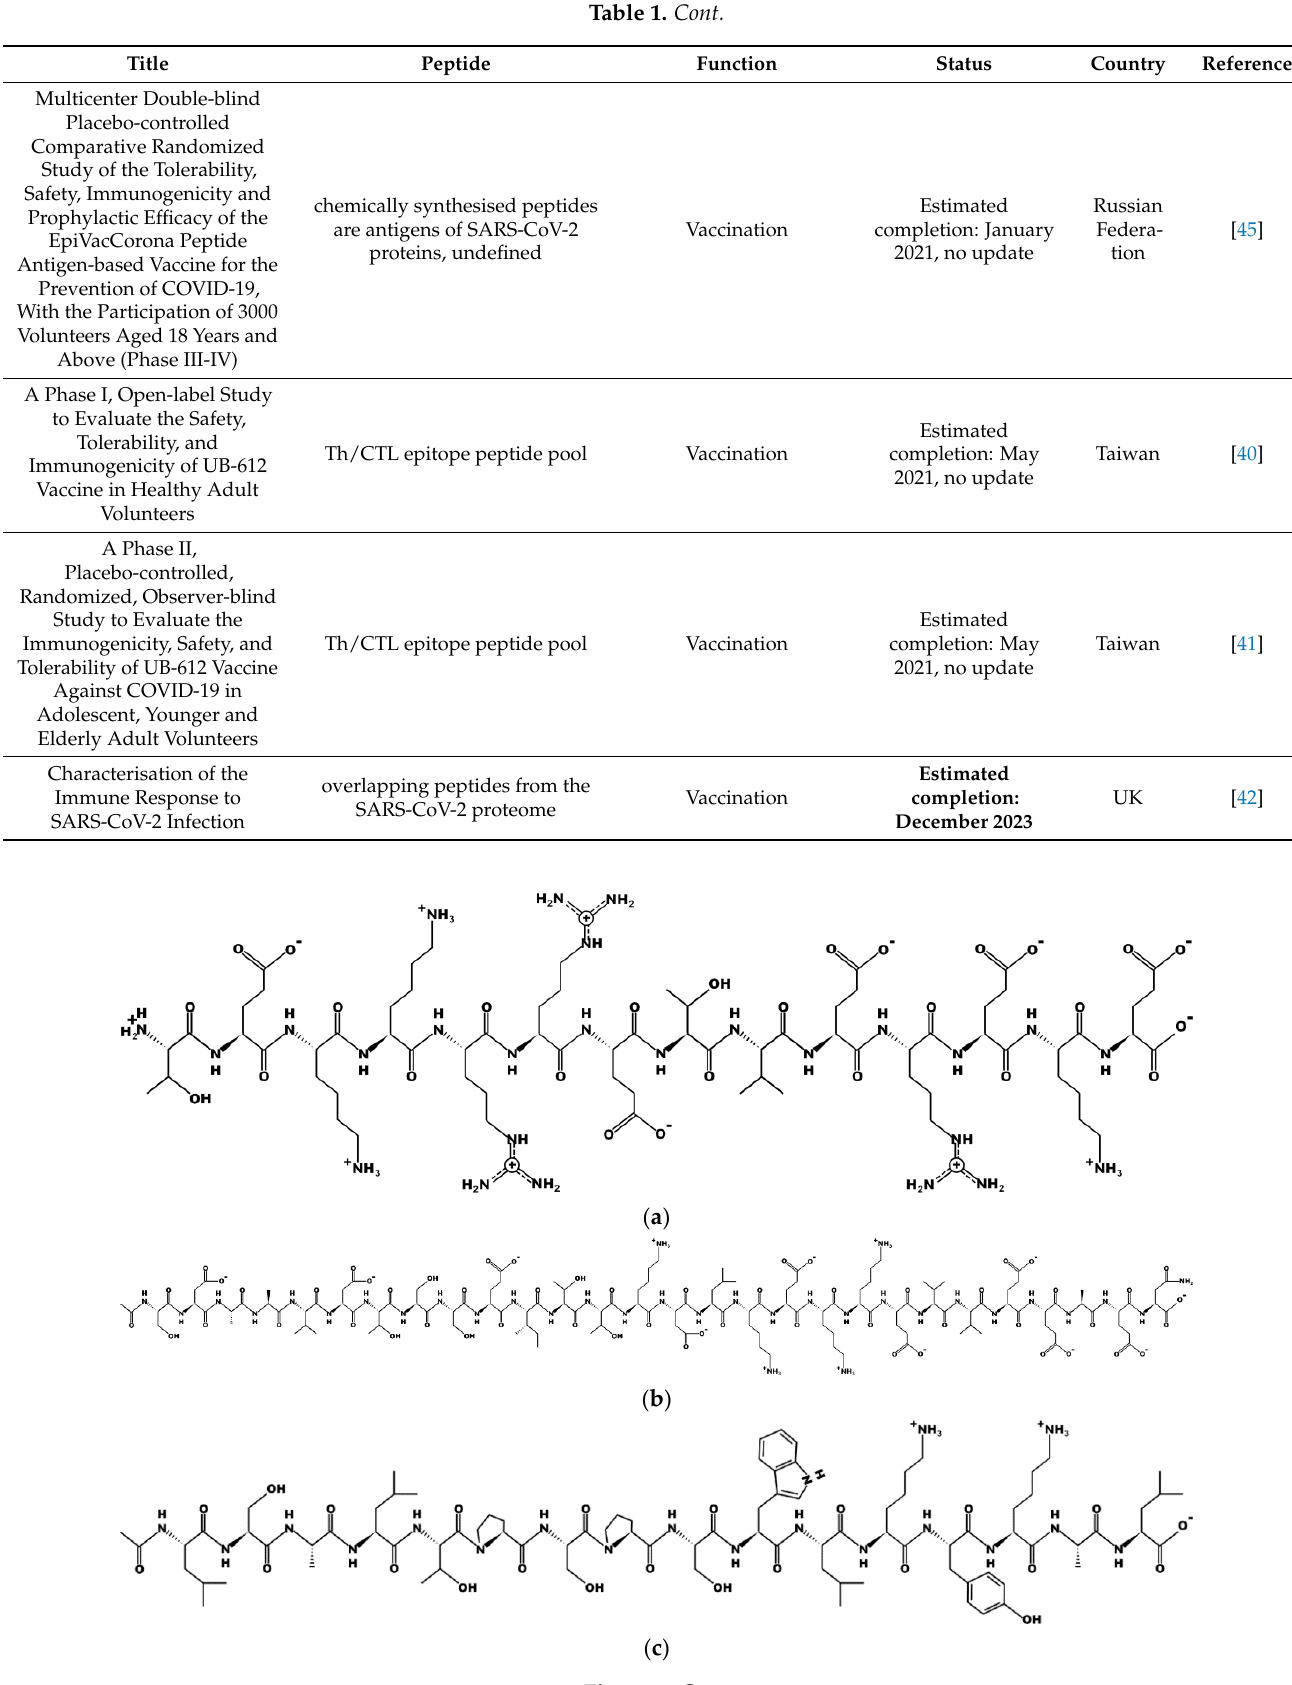
( d ) ( e ) Figure 1. Schematic representation of selected peptides used in clinical trials. ( a ) Human ezrin peptide 324-337, HEP1; ( b ) thymosin-alpha ;1 ( c ) LSALT peptide; ( d ) angiotensin peptide (1-7); ( e ) vasoactive intestinal peptide (VIP) using the pro- gram PEPDRAW (http://pepdraw.com/) (accessed on 7 October 2021). 3. Conclusions There are many peptides in the five different classes under investigation in the clini- cal trials examined in this review. It will take some time to evaluate the success of these approaches, especially given that 14 of these trials are not yet finished, and others have not yet made their data available. The jury is still out in regard to how successful peptides are in the fight against COVID-19. Funding: This research received no external funding.